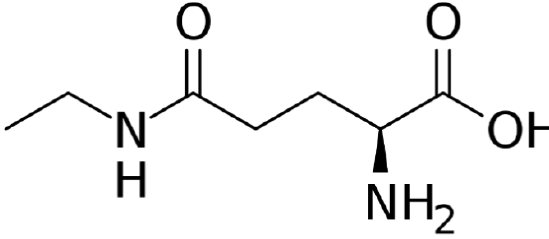
Figure 1. The structural formula of L -theanine [51].